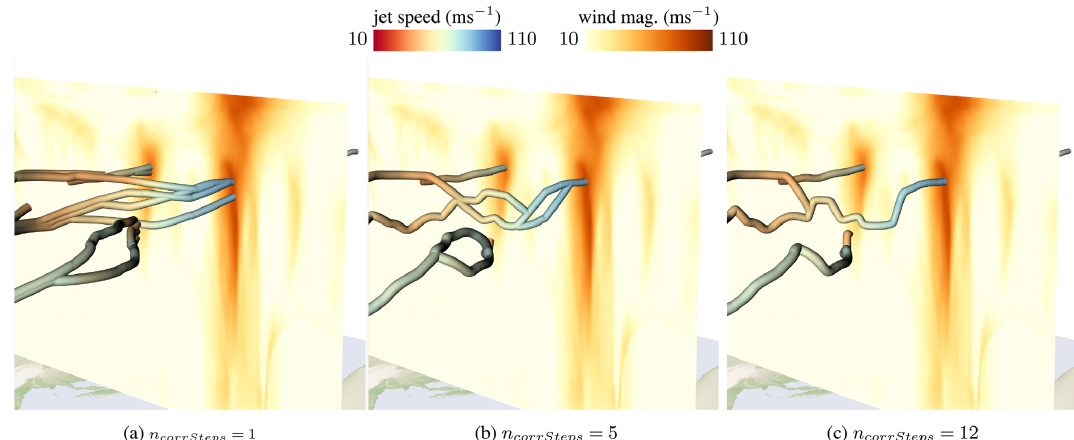
Figure 6. Comparison of jet core lines for varying number of correction iterations. The higher the number, the closer the line follows a ridge line, as proposed by Kern et al. (2017), which might exhibit higher curvature. Lowering the number of corrector iterations smoothes the line. A cross section of the wind magnitude field shows how well the extracted core lines pass through sectional extrema. The data here are for 11 September 2016 at 15:00UTC.